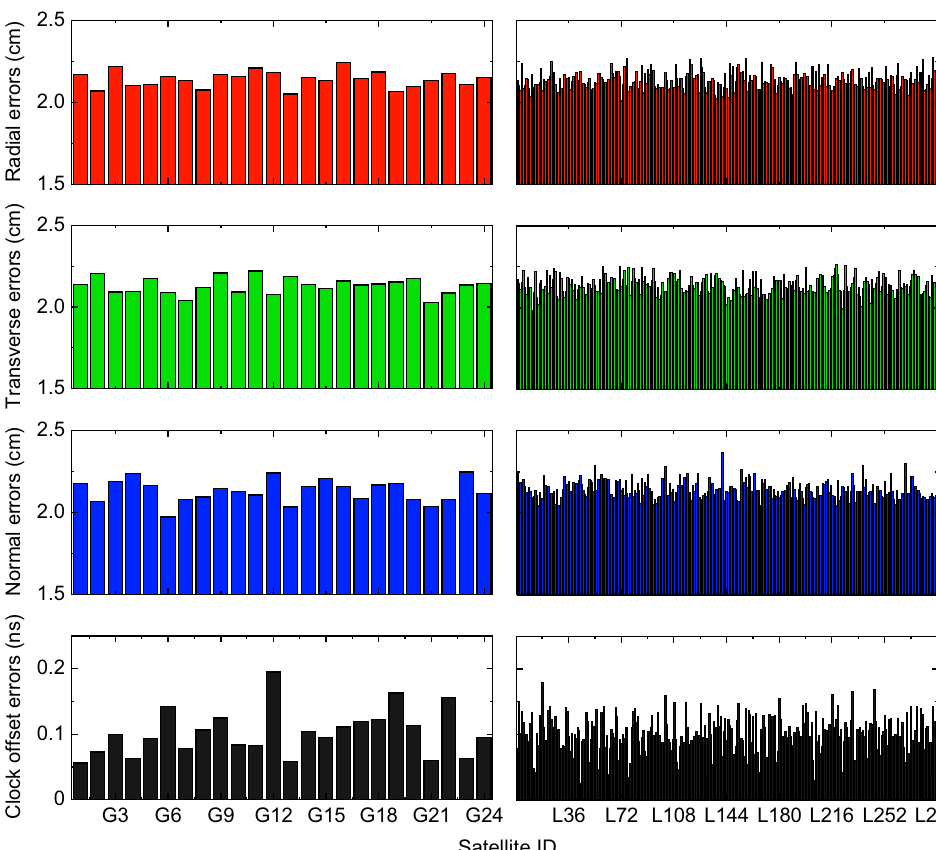
Fig. 3 RMS of GPS and LEO satellites orbit errors in the radial, transverse, normal directions, and clock offset